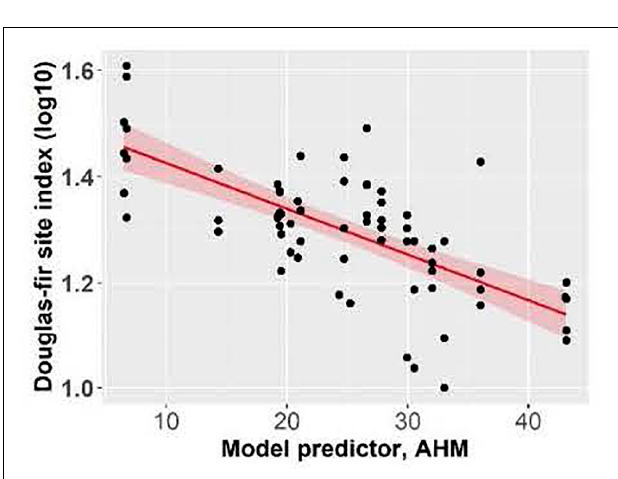
FIGURE 3 | Effect of annual heat moisture index (AHM) on Douglas-fir site index. Linear mixed-effects models were used to estimate marginal R 2 = 0.41. Each point represents one measurement per plot (113 plots in total). Douglas-fir site index was log-transformed, and the figure presents log10-transformed